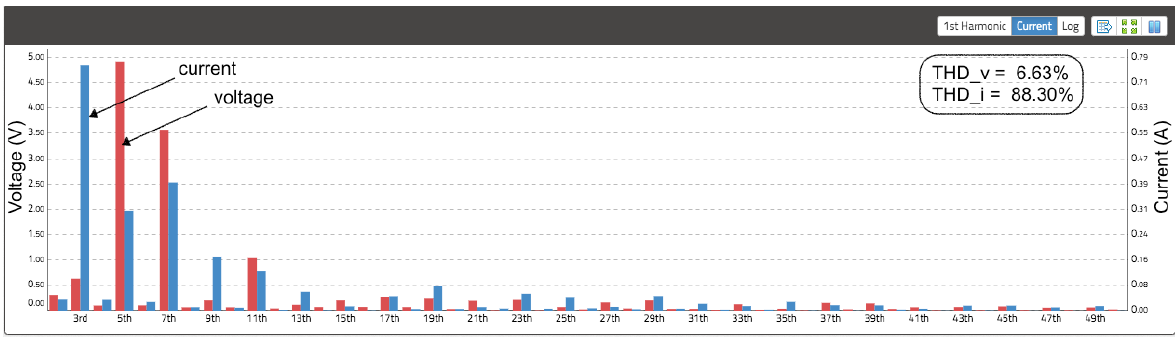
Figure 3. Voltage and current waveform measurements at a residential installation in Spain.